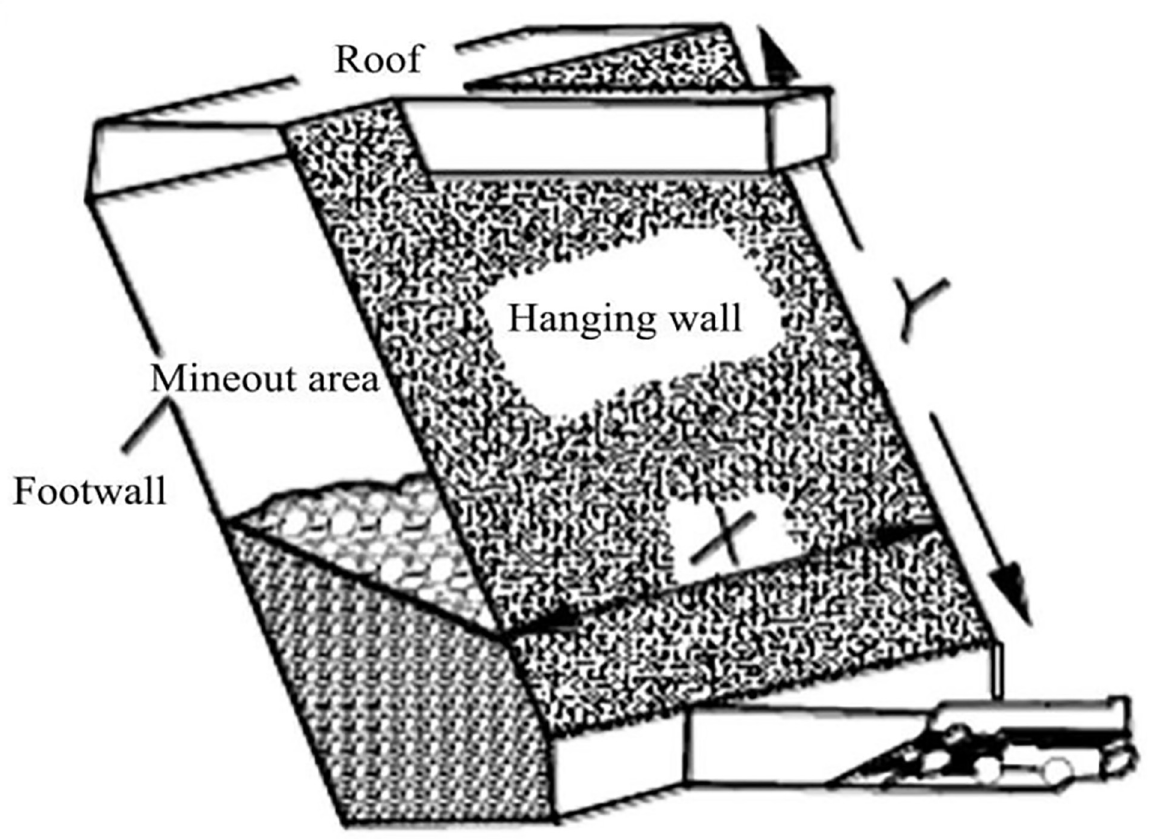
Fig 2. Hydraulic radius determination method